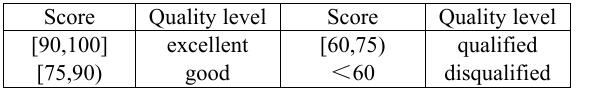
Table 3. Quality